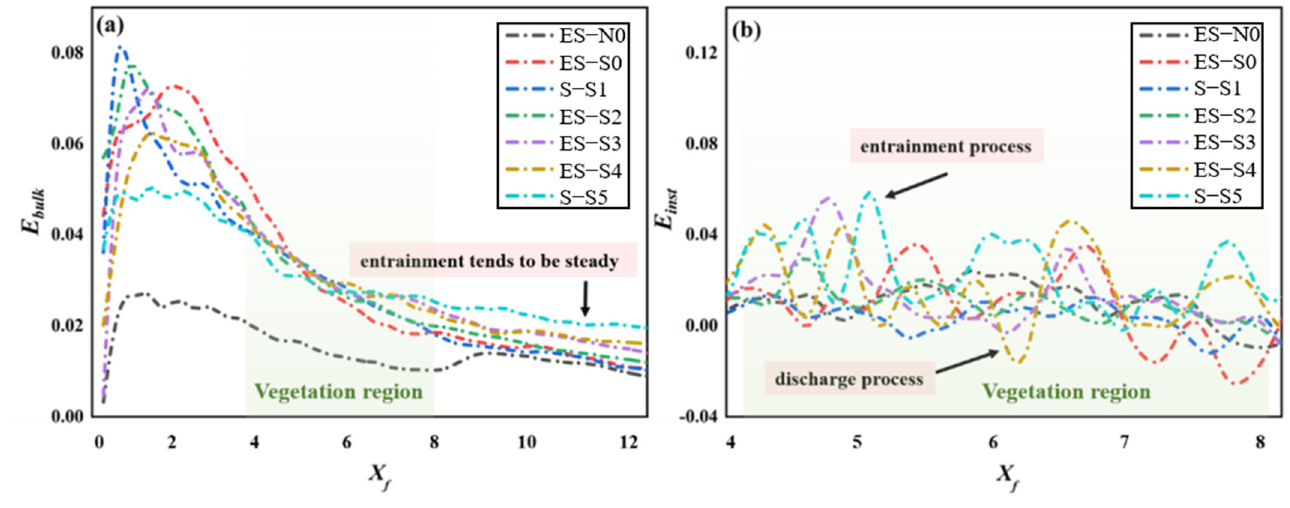
Figure 8. Spatial evolution of the three-dimensional bulk entrainment coefficient buik E ( a ) or in- neous entrainment coefficient E inst ( b ). The light green rectangle marks the vegetation stantaneous entrainment coefficient inst E ( b ). The light green rectangle marks the vegetation re- gion.